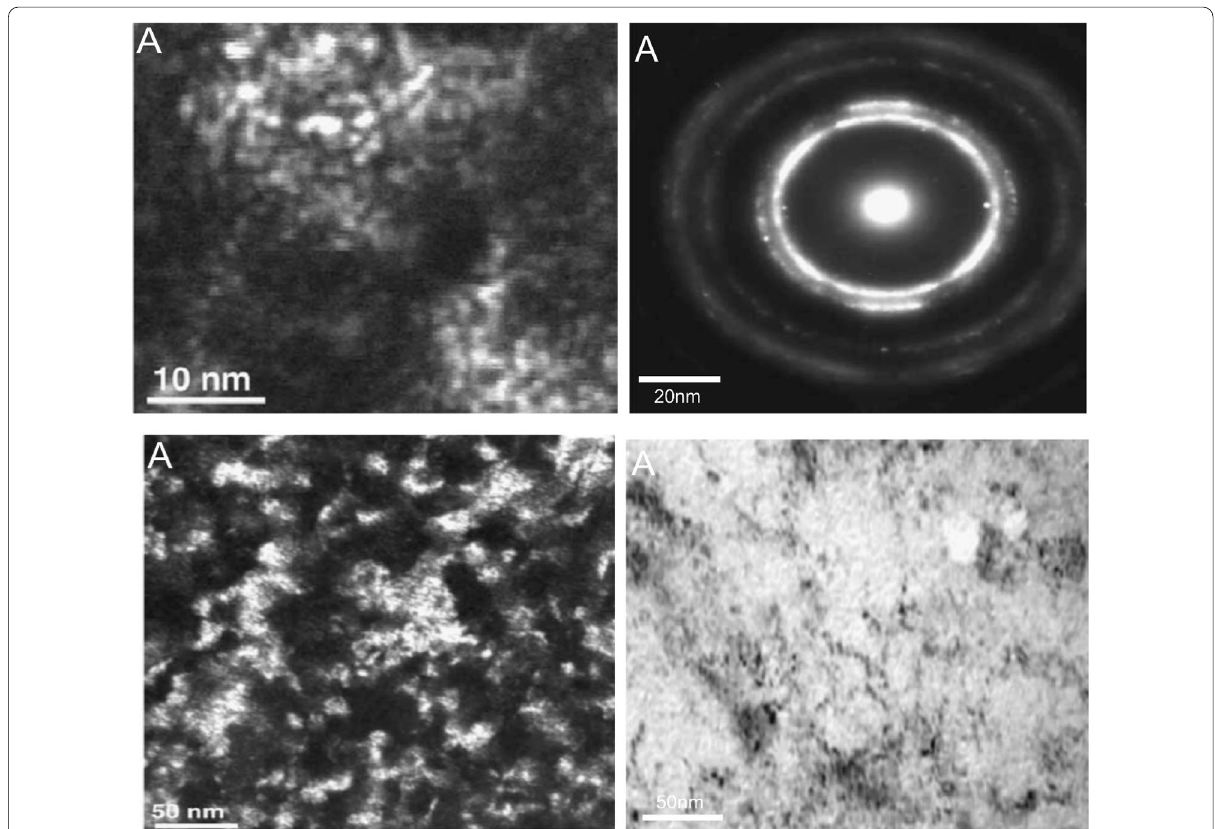
Fig. 4 TEM microtopography showing the particle size and light permeability of the film